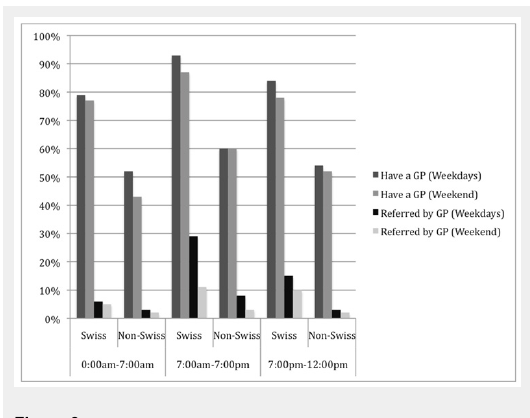
Figure 3 Patients having a general practitioner (GP) and patients being referred by a GP for Swiss vs. Non-Swiss patients on weekdays and